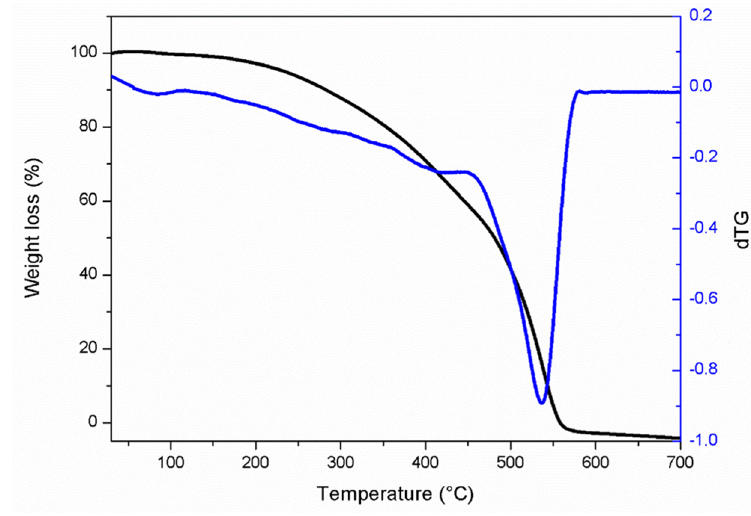
Figure 4. Thermogravimetric analysis for lignin recovered from eucalyptus.